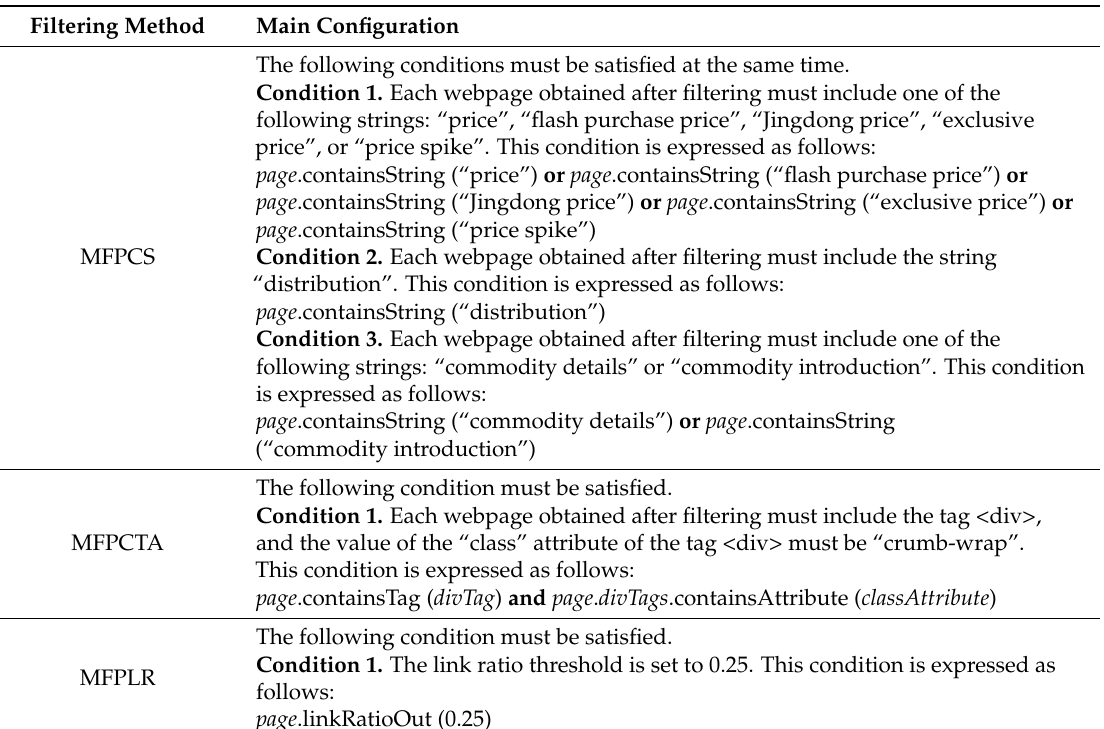
Table 2. The main configuration of four